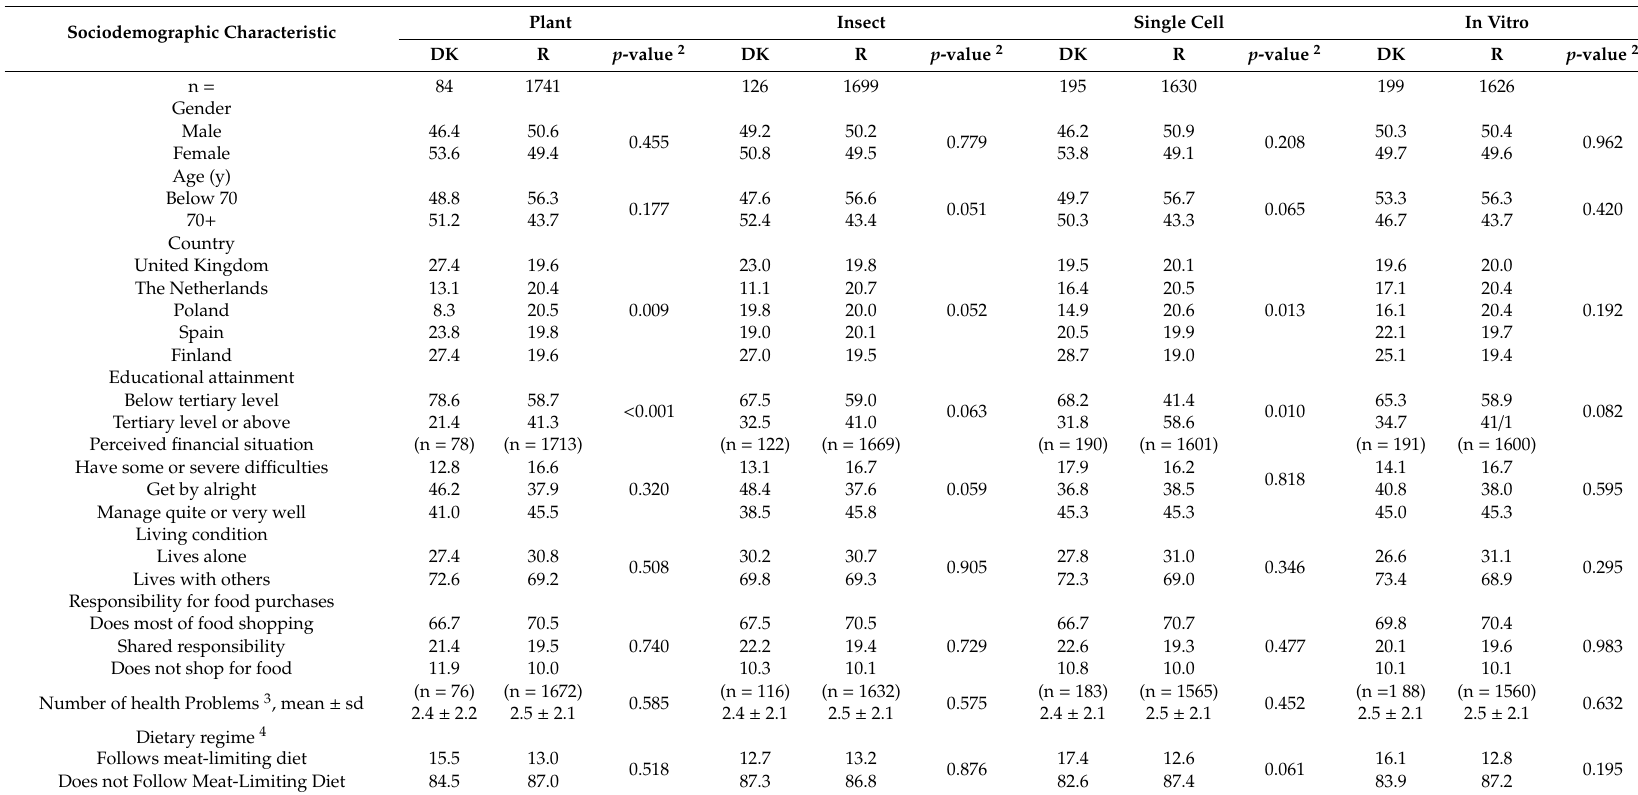
Table A3. Sociodemographic characteristics of the sample who responded ‘I don’t know’ (DK) versus the sample who responded in the ordered scale (R) (very unacceptable ( = 1) to very acceptable ( = 5)) when asked to what extent they eat foods containing a sustainable protein source 1 . Sociodemographic Characteristic